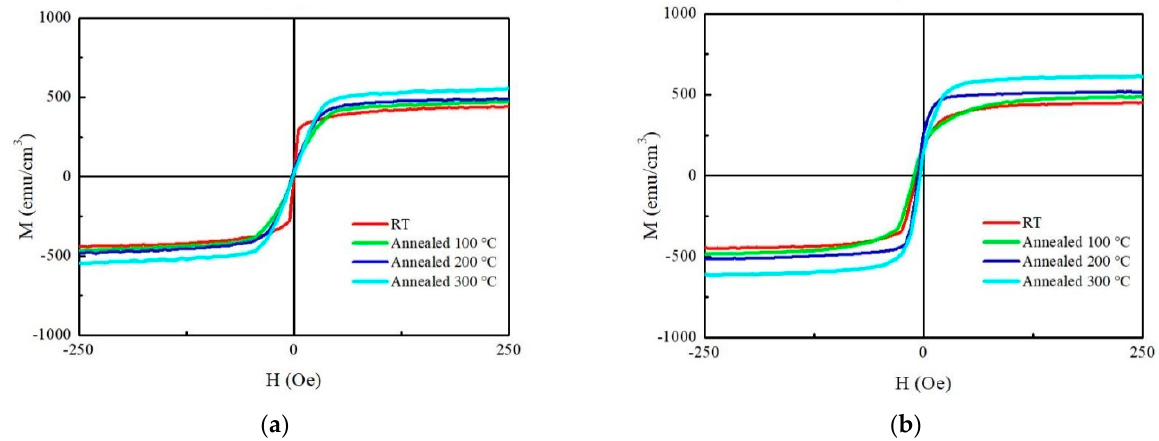
Figure 6. M-H loop of CoFeY fi lms under four conditions; ( a ) 10 nm and ( b ) 50 nm.